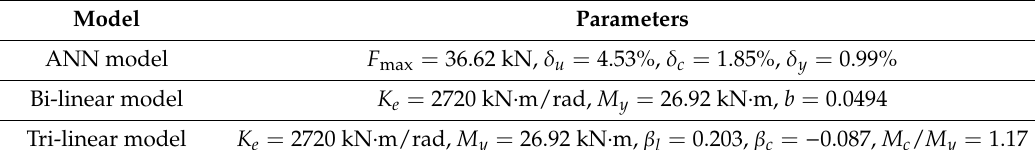
Table 6. ANN-based method for the LP model of RC column sample S2 [43].